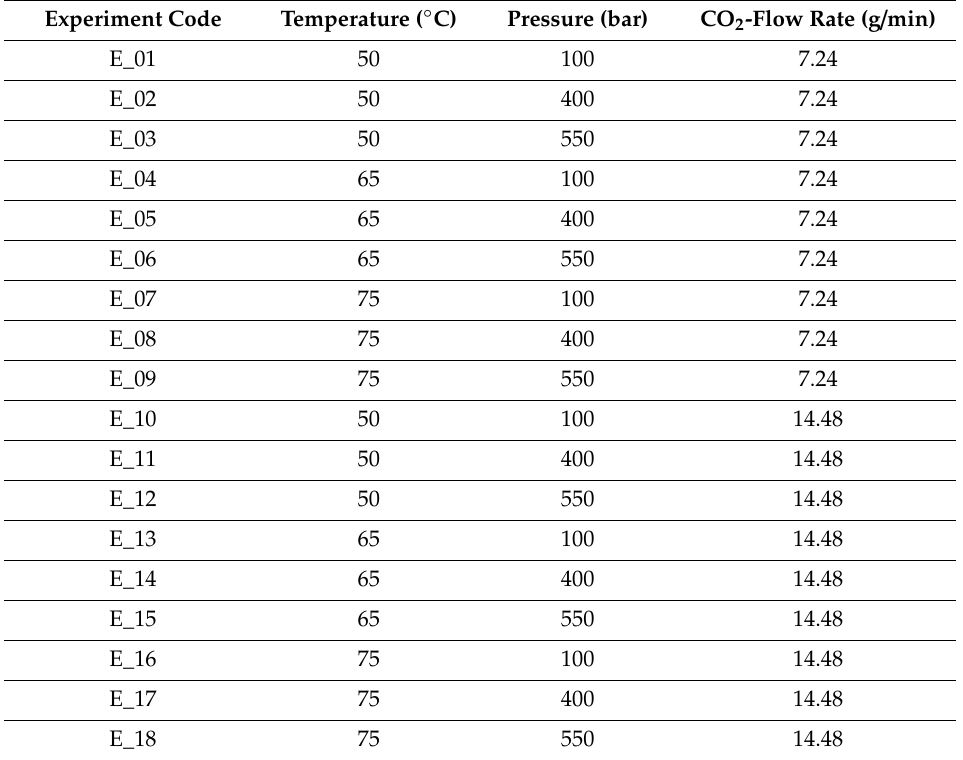
Table 5. The experimental condition during SF-CO 2 extraction for lipid recovery from Nannochloropsis sp.